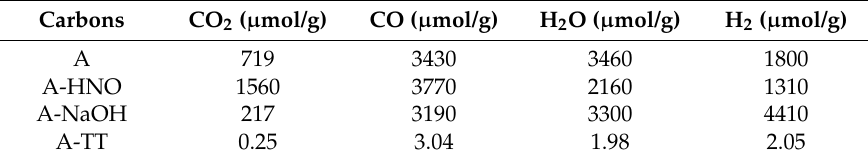
Table 2. Quantification of the chemical surface groups (meq·g −1 ) by Boehm titration.